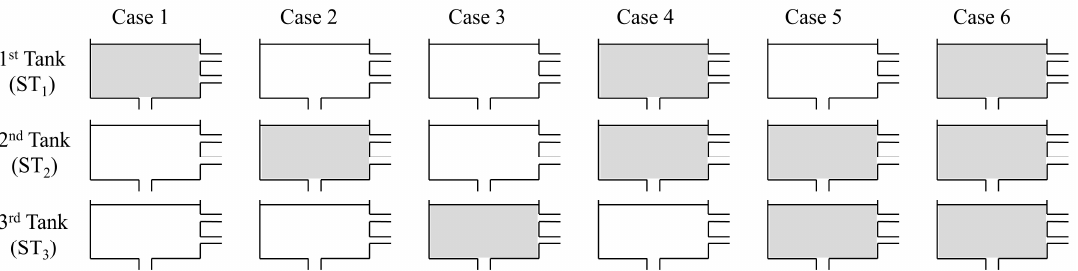
Figure 7. Schematic representation of six different tank combinations. Grey-colored tanks refer to the tanks used in comparison with in situ soil moisture (SM) observations.